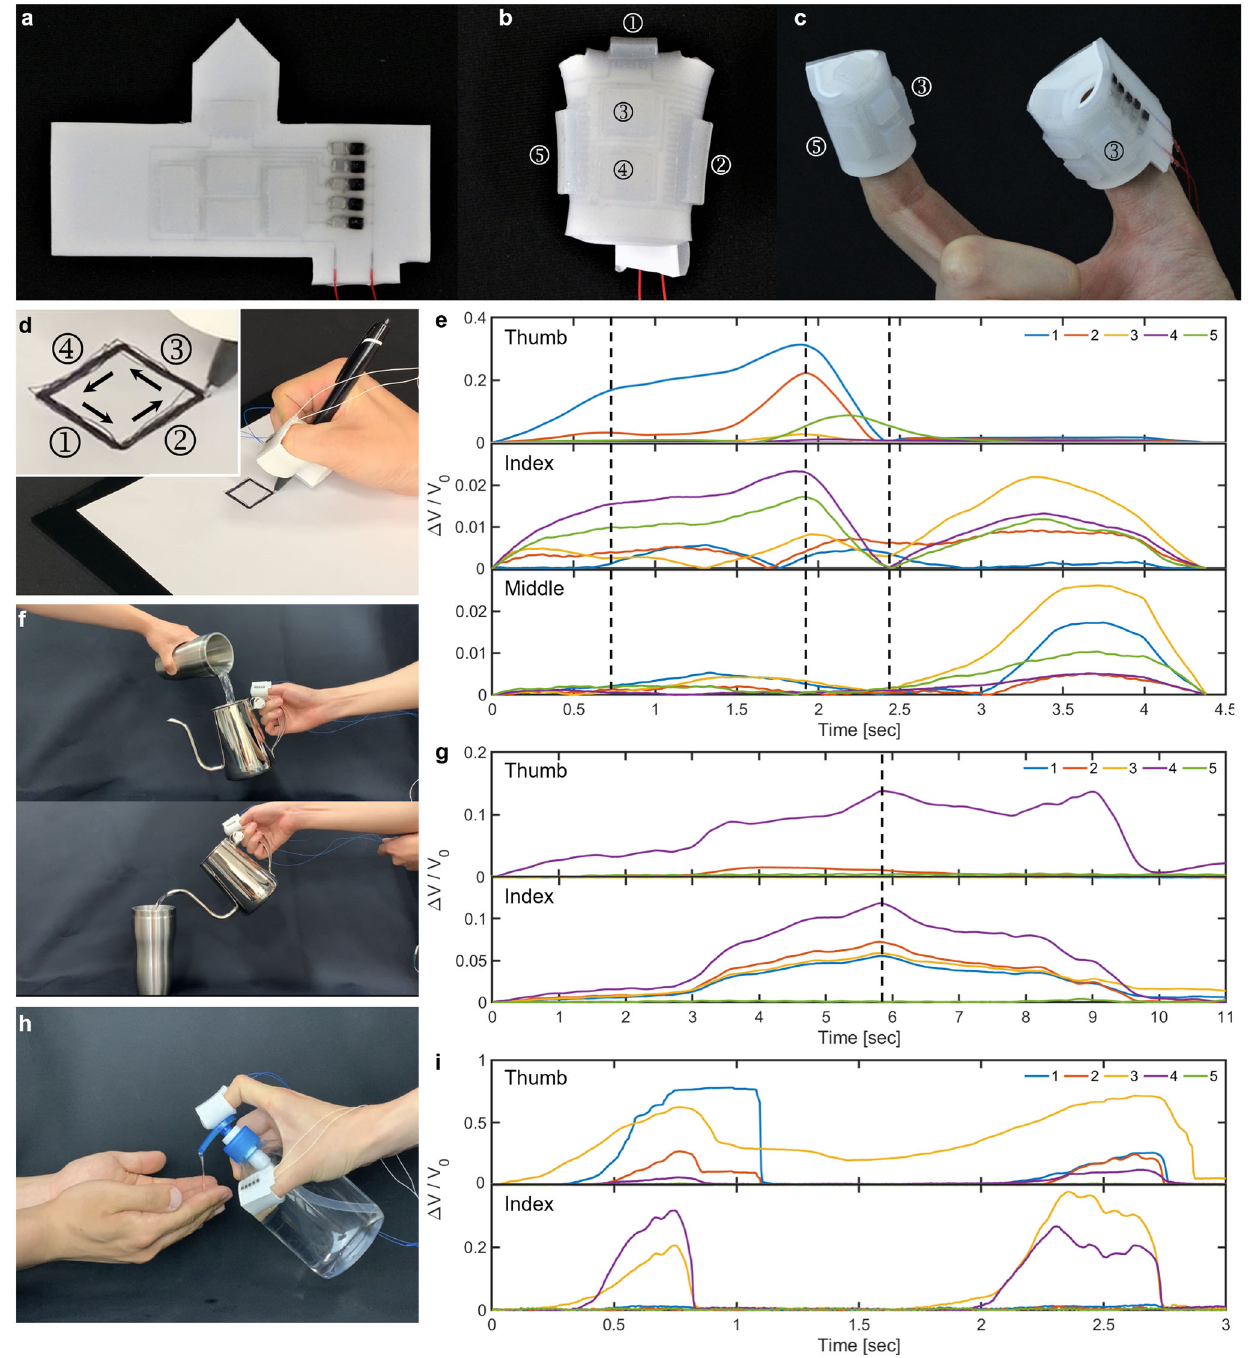
Fig. 3 Fingertip sensor experiments and results. a 2D con fi guration before being rolled up, b complete prototypes worn on thumb and an index fi nger, and c numbering of sensing modules. d Pen drawing experiment and e the result. f Water pouring experiment and g the result. h Push and squeeze experiment and i the